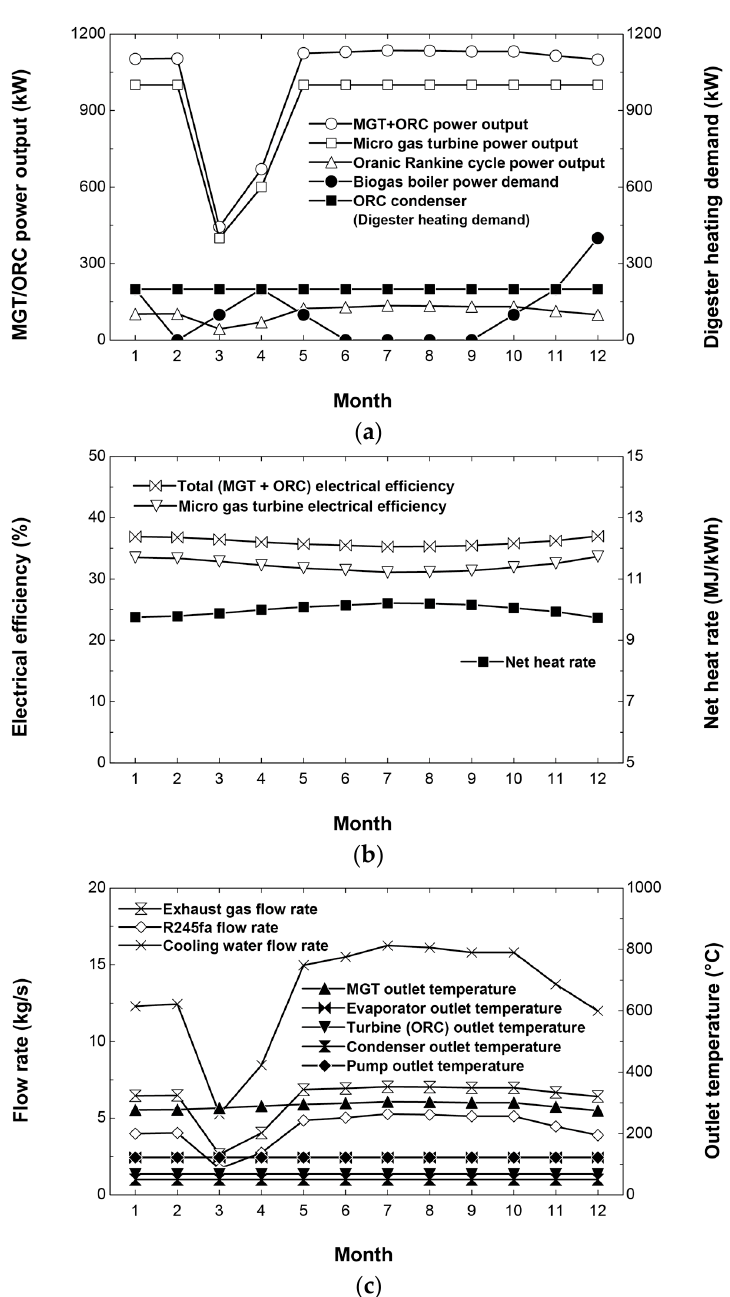
Figure 10. Annual operating results for MGT with bottoming ORC. ( a ) The power output of the MGT and the ORC, the amount of the biogas used in the biogas boiler and the amount of the heat transferred from the ORC condenser; ( b ) The electrical efficiency of the MGT and the MGT with the ORC. The net heat rate of the MGT with the ORC; ( c ) The mass rate and the outlet temperature for the streams in the MGT and the ORC.